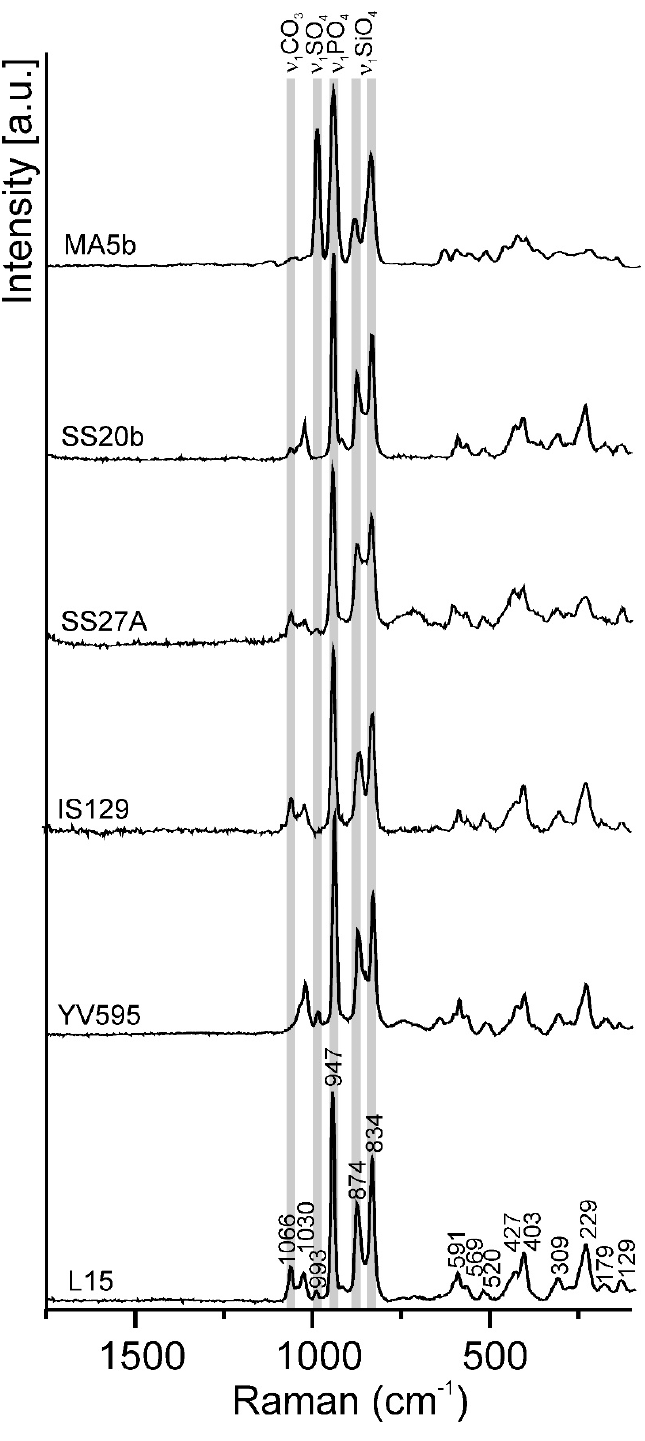
Figure 2. Raman spectra of ariegilatite: holotype specimen, Negev Desert, Israel (Sample Number L15 ); gehlenite-larnite rock, Daba-Siwaqa, Jordan ( YV595 ); apatite-spurrite rock, Gurim Anticline, Negev Desert ( IS129 ); spurrite rock, Daba-Siwaqa, Jordan ( SS27A and SS20b ); exsolution structures after flamite ( MA5b ). Grey vertical bars show the positions of characteristic bands of stretching vibrations ( υ 1 ) in tetrahedral anion groups and (CO 3 ) 2 − .